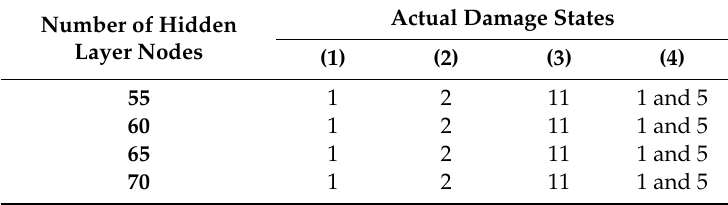
Table 9. Damage detection results of experimental data (high-speed